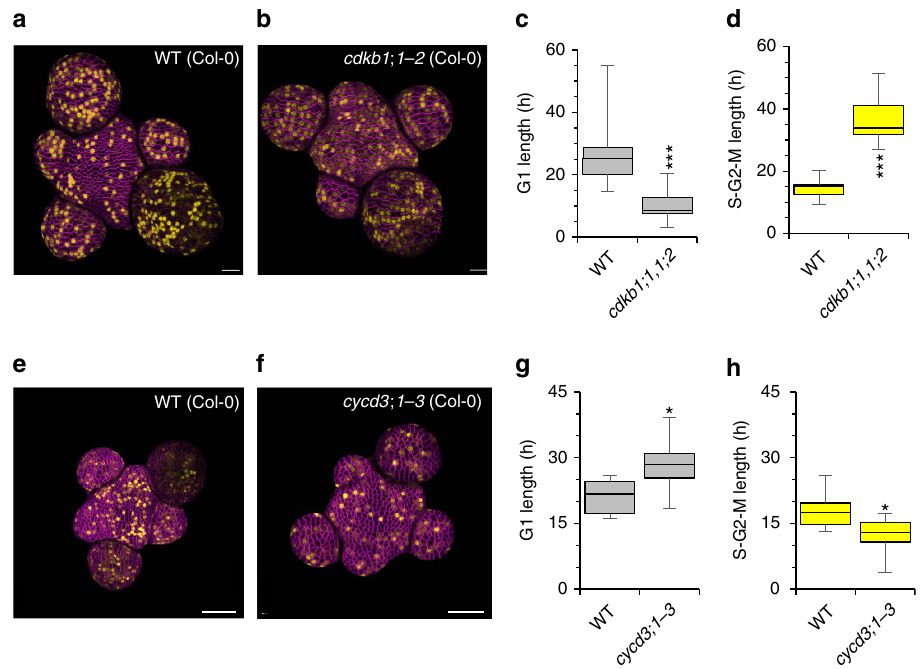
Figure 8 | Mutant analysis suggests length of G1 and S-G2-M is size dependent. ( a , b ) Surface projections of WT (Col-0) ( a ) and cdkb1;1/1;2 double mutant plants ( b ) expressing H4::DB-VENUS . VENUS signal is shown in yellow. Cell membranes are shown in magenta. Scale bars represent 20 m m. ( c ) Distribution of mean G1 length in WT (Col-0) and cdkb1;1/1;2 plants. Data represent mean values from 13 and 11 plants respectively. ( t -test, t ¼ 4.6858, df ¼ 19.854, P ¼ 0.0001) ( d ) Distribution of mean S-G2-M length in WT (Col-0) and cdkb1;1/1;2 plants. Data represent mean values from 13 and 11 plants respectively. ( t -test, t ¼ (cid:2) 4.6858, df ¼ 19.854, P ¼ 0.0001) ( e , f ) Surface projections of WT (Col-0) ( e ) and cycd3;1-3 triple mutant plants ( f ) expressing H4::DB-VENUS . VENUS signal is shown in yellow. Cell membranes are shown in magenta. Scale bars represent 50 m m. ( g ) Distribution of mean G1 length in WT (Col-0) and cycd3;1-3 plants. Data represent mean values from 9 and 7 plants respectively. ( t -test, t ¼ 2.6144, df ¼ 9.129, P ¼ 0.02775) ( h ) Distribution of mean S-G2-M length in WT (Col-0) and cycd3;1-3 plants. Data represent mean values from 9 and 7 plants respectively. ( t -test, t ¼ (cid:2) 2.6144, df ¼ 9.129, P ¼ 0.02775) *, **, *** indicate a significance at the 0.05, 0.01 and 0.001 levels respectively. Error bars show total